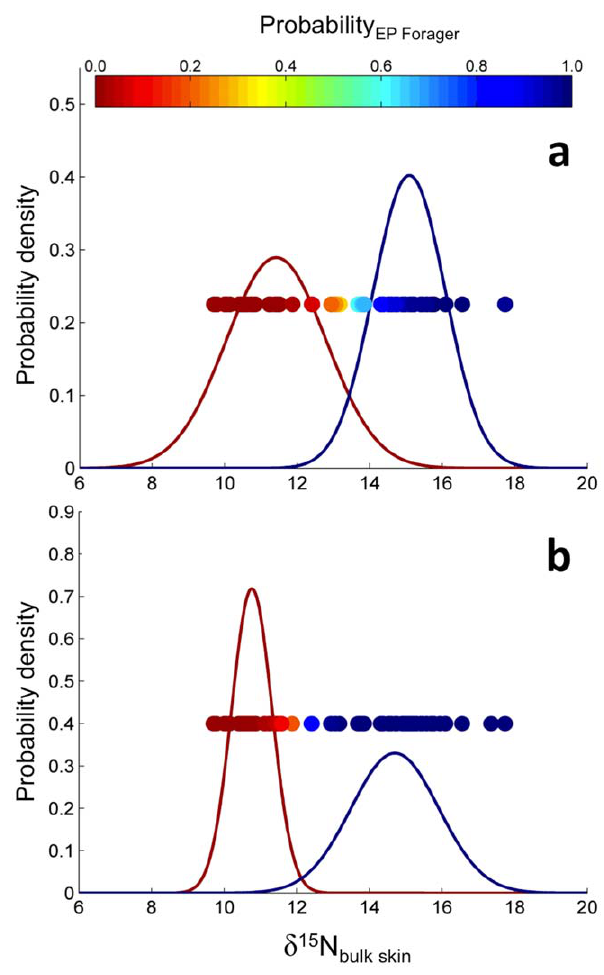
Figure 5. Marginal posterior distributions of d 15 N values for the two assumed foraging grounds (bell-shaped curves) and individual assignments to one of the two foraging grounds (filled circles in horizontal arrangement) with color-coded probabilities of belonging to the eastern Pacific foraging area. Panel A is from Model 4, whereas the Panel B is from Model 6. For both models, posterior distributions depicted in red are from the ‘low d 15 N’ (i.e. putative western Pacific foragers), whereas those in blue represent the ‘high d 15 N’ group (i.e., putative eastern Pacific foragers).